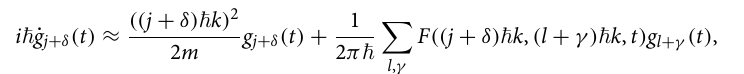
Figure 10. Visualisation of different momentum couplings from the 0 (cid:31) k momentum wavepacket corresponding to different levels of complexity. (a) Zero momentum width and two coupling elements from 0 (cid:31) k to 2 (cid:31) k . (b) Finite momentum widths with coupling elements for each momentum component in the ± 0 (cid:31) k wavepacket to the corresponding momentum component in the 2 (cid:31) k wavepackets with a momentum ± 2 (cid:31) k . The different colours indicate the separate momentum subspaces in difference for each transition of (cid:31) p = which transitions can occur. (c) Finite momentum widths with multiple possible coupling elements from the 0 (cid:31) k wavepacket to the 2 (cid:31) k wavepacket with a broadening of the possible momentum difference (cid:31) p . (d) Finite ± momentum widths with higher order coupling elements from the 0 (cid:31) k wavepacket to momentum components of 4 (cid:31) k , 6 (cid:31) k , . . . the ± ±